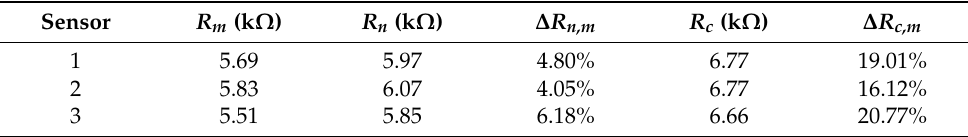
Table 1. Measured ( R m ), numerically ( R n ) and analytically ( R c ) calculated reference resistances, and the relative differences ( ∆ R ) for three sensors with d = 20 mm, w = s = 2 mm, h = 0.5 mm.